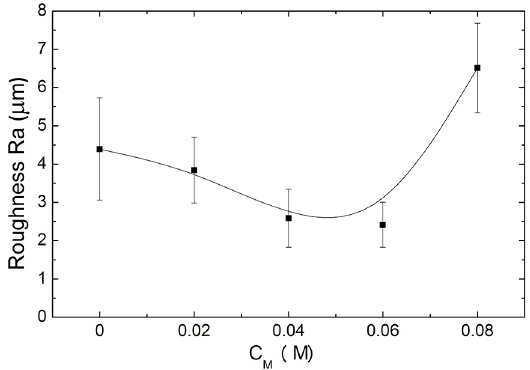
Figure 4. Roughness of titanium samples treated by PEO at different C . M